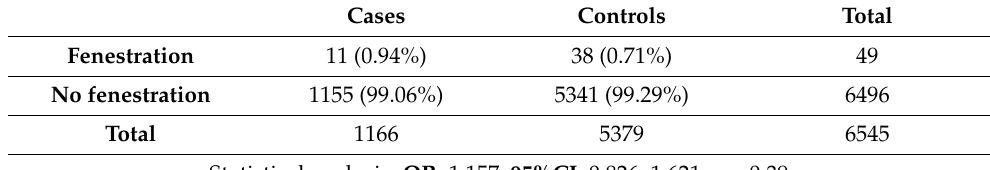
Table 2. Association between cerebral arterial fenestrations and brain aneurysms (contingency 2 × 2 table). Cases